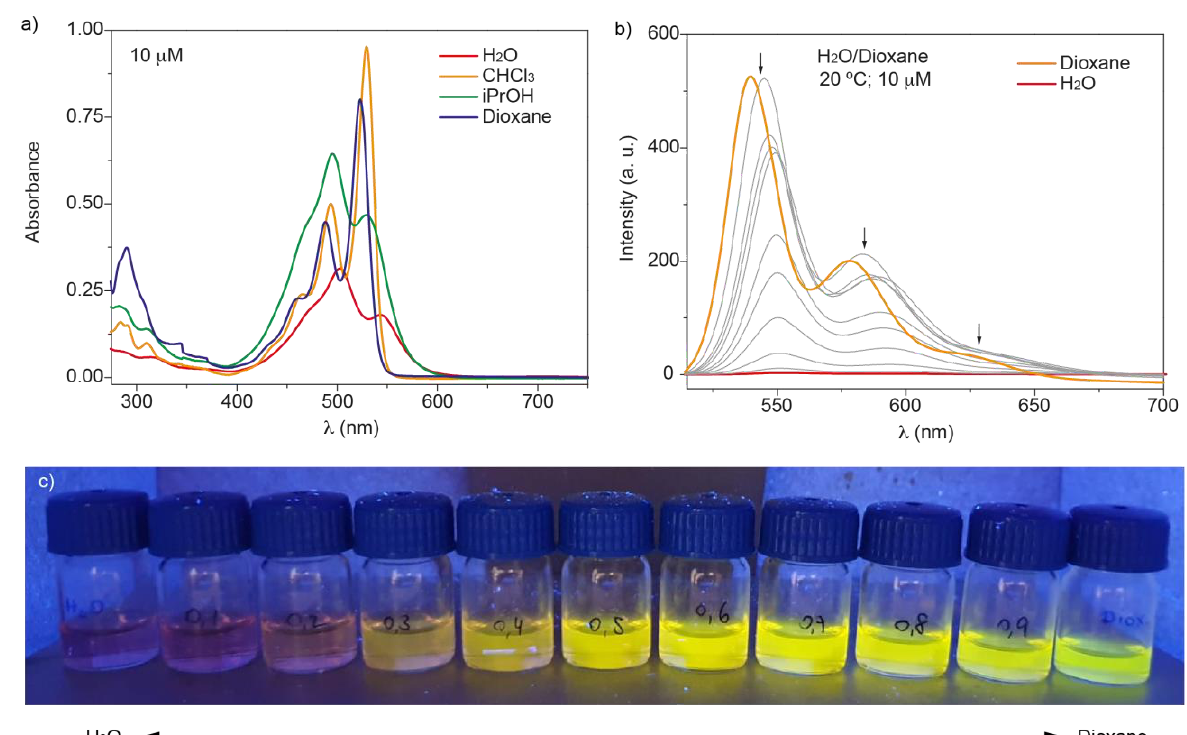
Figure 3. ( a ) UV-Vis spectra of 1 in different solvents; ( b ) emission spectra of 1 in water, dioxane, and mixtures water/dioxane at different ratios ( λ exc = 493 nm); ( c ) pictures of the emissive character of the solutions of 1 in water, dioxane, and mixtures water/dioxane at different ratios under illumination at 365 nm. Experimental conditions: c T = 10 µ M, 20 ◦ C.